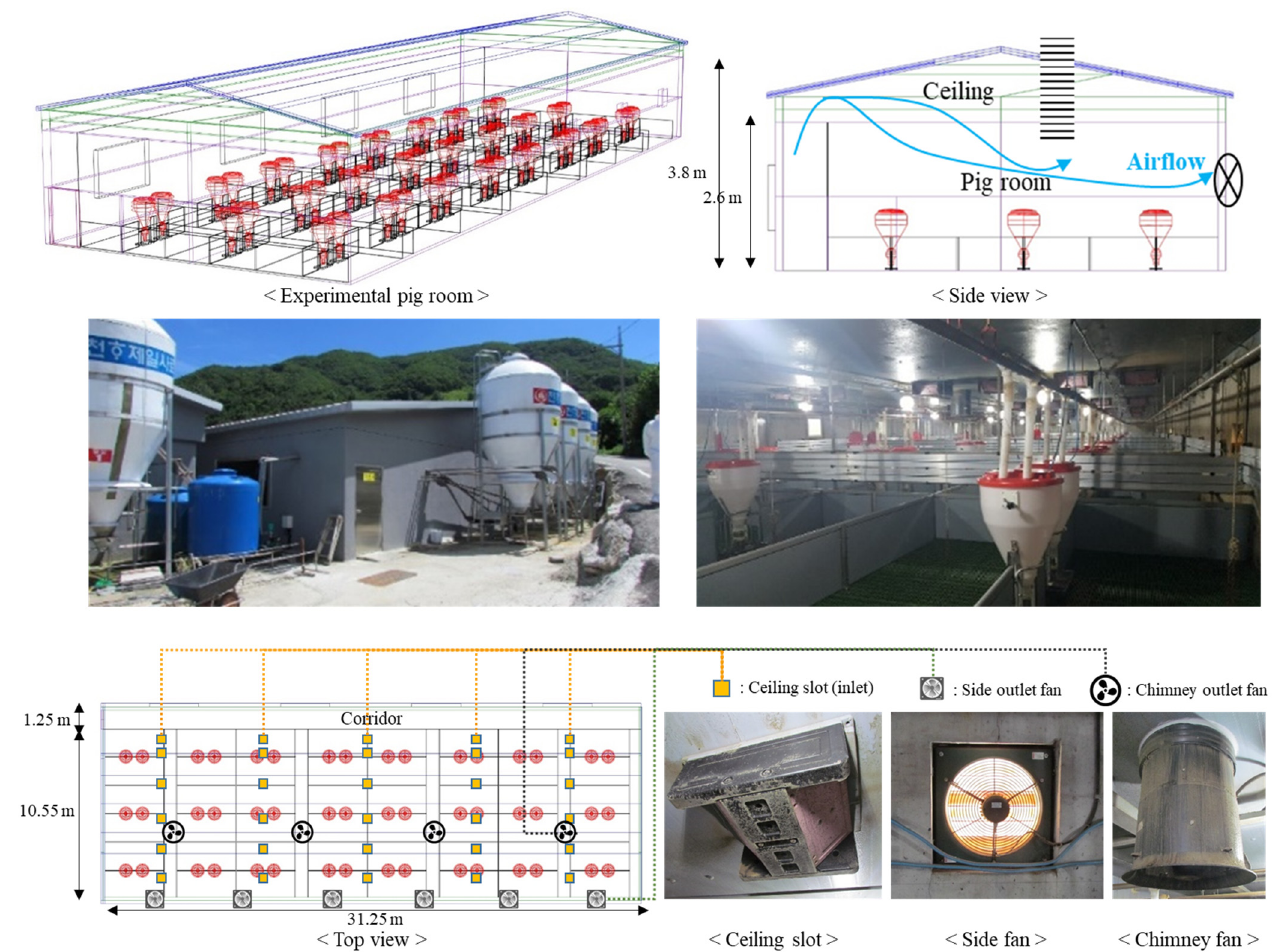
Figure 4. The structure and ventilation system of the experimental pig house .